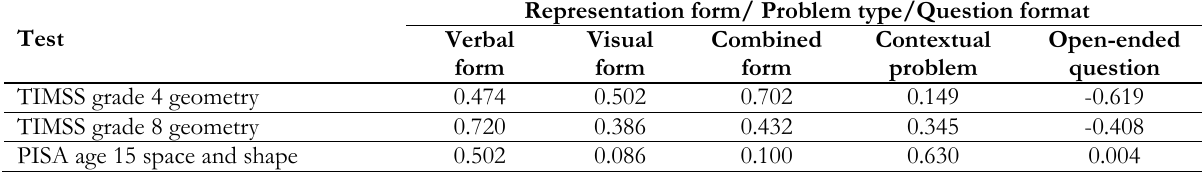
Table 4. Pearson correlation coefficients ( r ) between each pair of variables listed Test